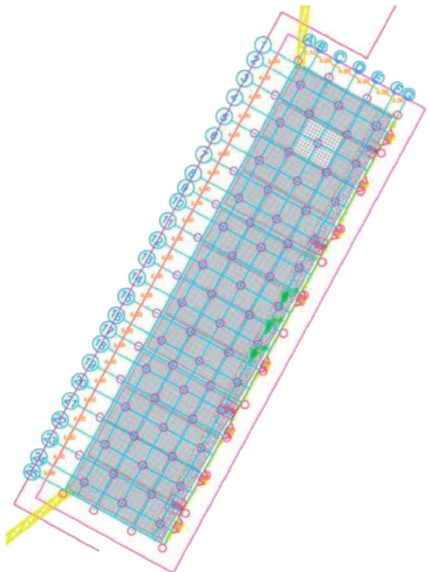
Figure 25: Plan of the second-stage piling.